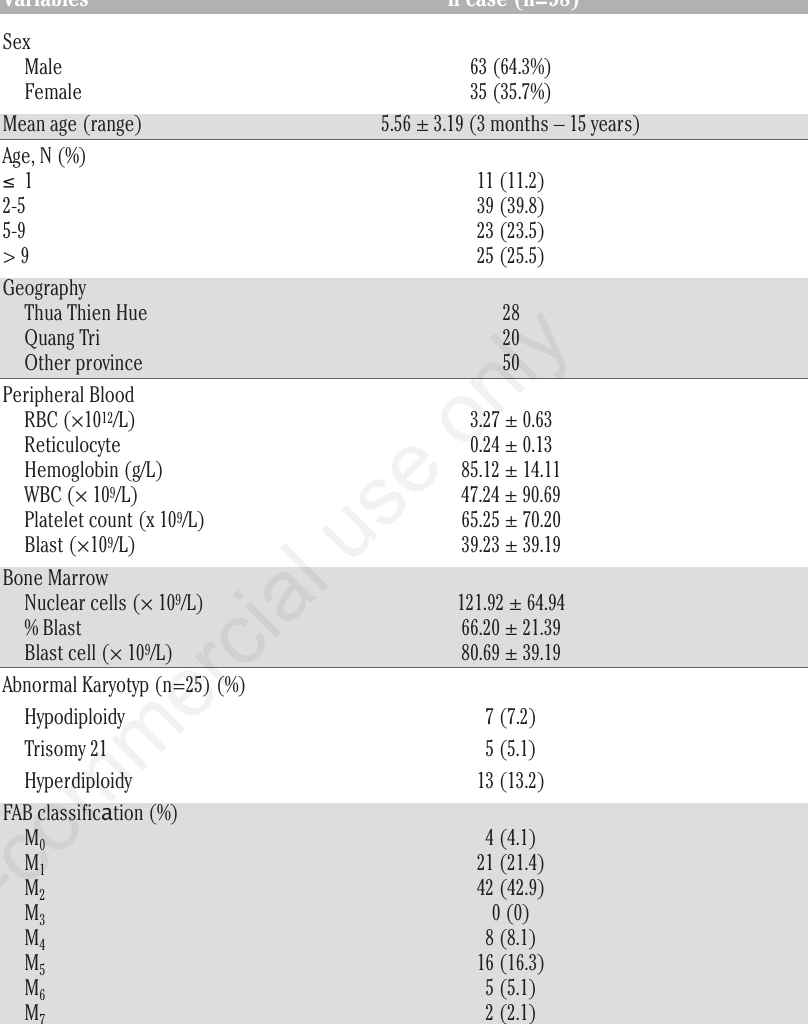
Table 3. Demographic characteristics of childhood acute myeloid leukemia by study period. Variables